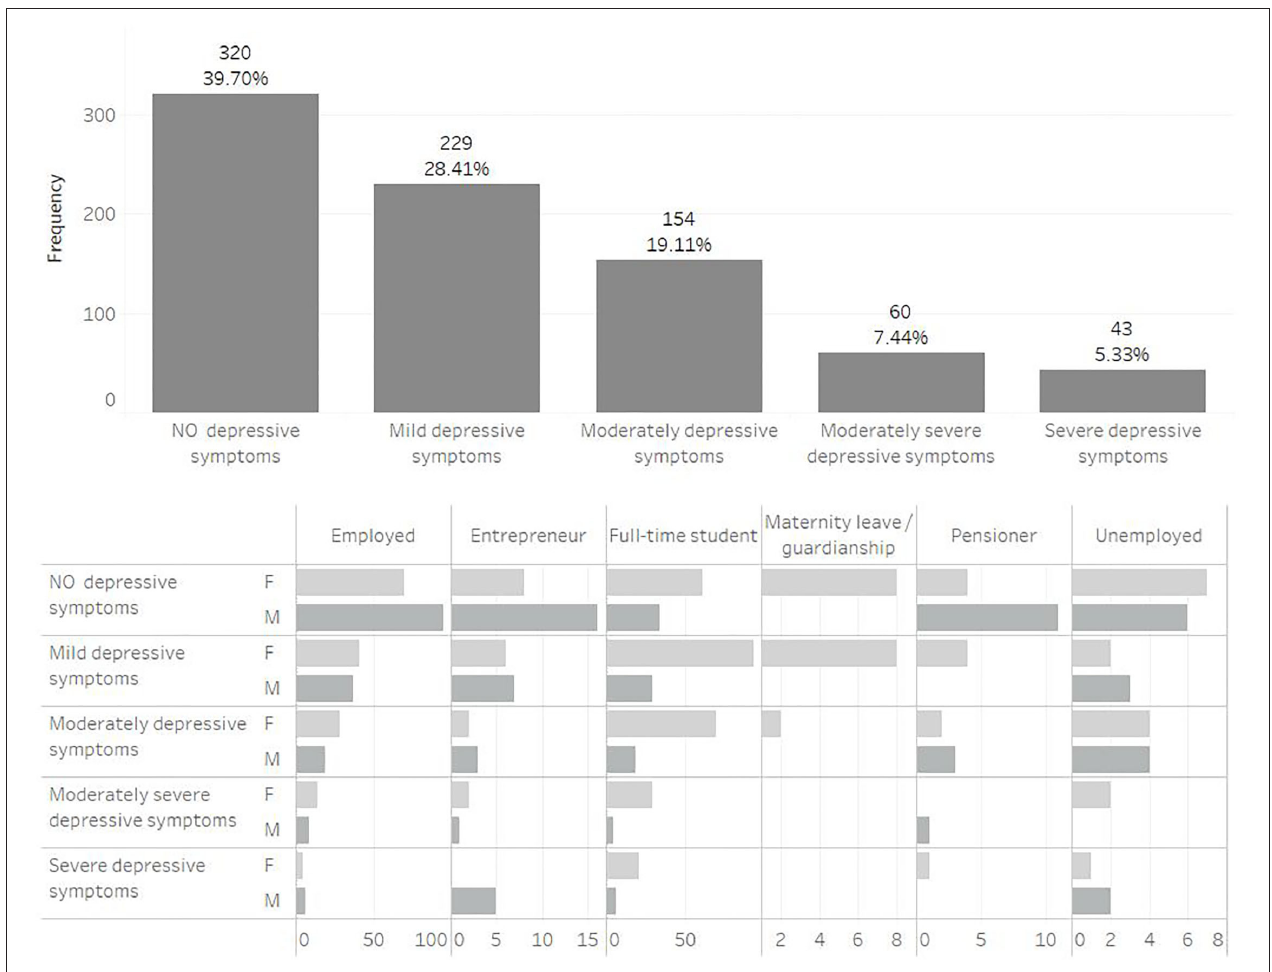
FIGURE 1 | Frequency of depressive symptoms among Slovak